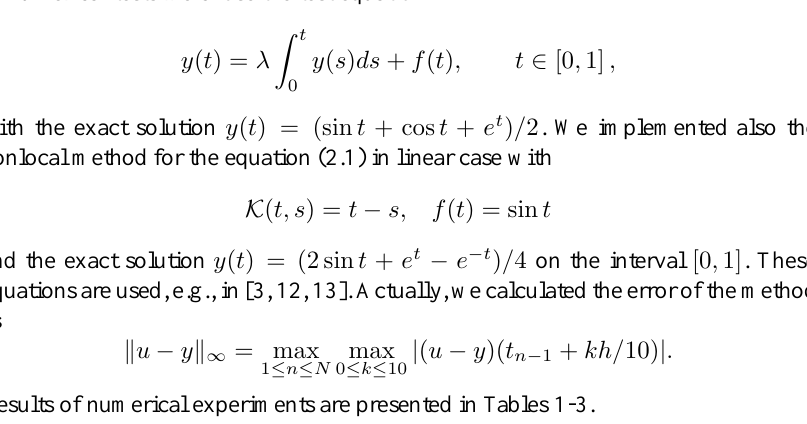
Table 1. Numerical results for y ( t ) = (cid:21) R t N 4